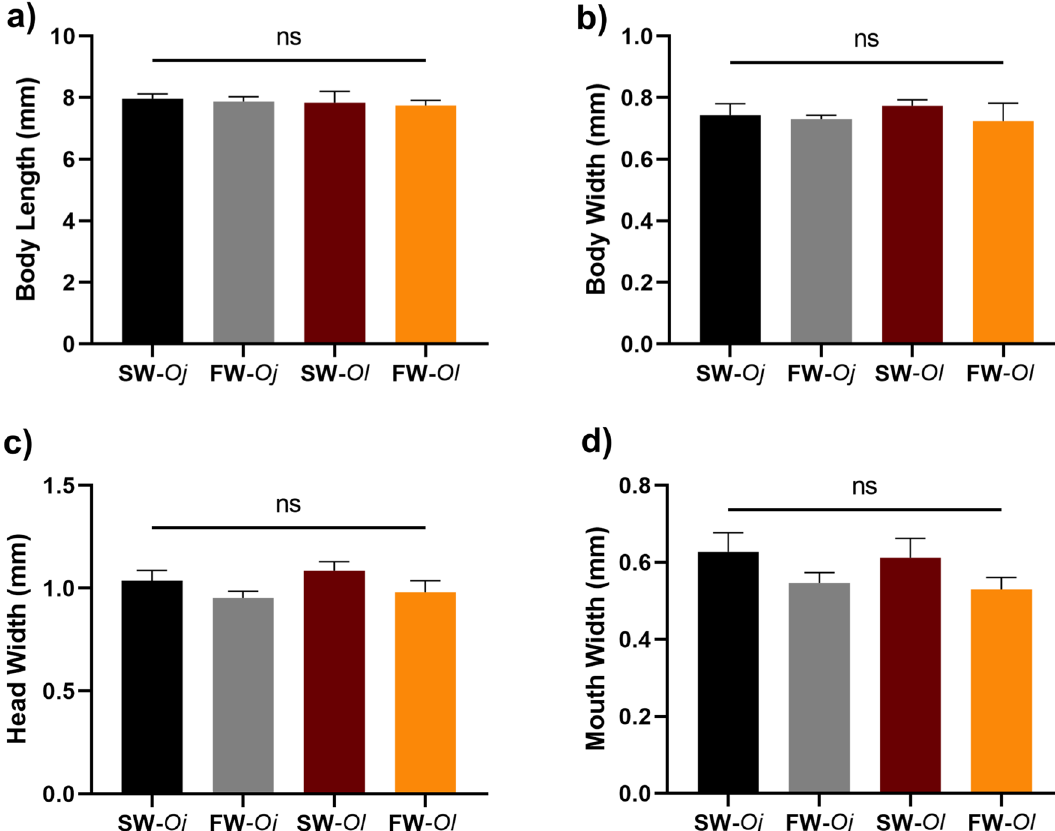
Figure 5. Body Measurements of Oryzias javanicus and O. latipes larvae reared in freshwater and seawater. ( a ) Body length, ( b ) Body width, ( c ) Head width, ( d ) Mouth width. Morphological features of each medaka group were measured using a microscope. The black bar indicates seawater-reared O. javanicus (SW- Oj ). The grey bar indicates freshwater-reared O. javanicus (FW- Oj ). The brown bar shows seawater-reared O. latipes (SW- Ol ), whereas the orange bar shows freshwater-reared O. latipes (FW- Ol ). Differences between areas were analyzed for significance using one-way ANOVA ( ns non-significant P >